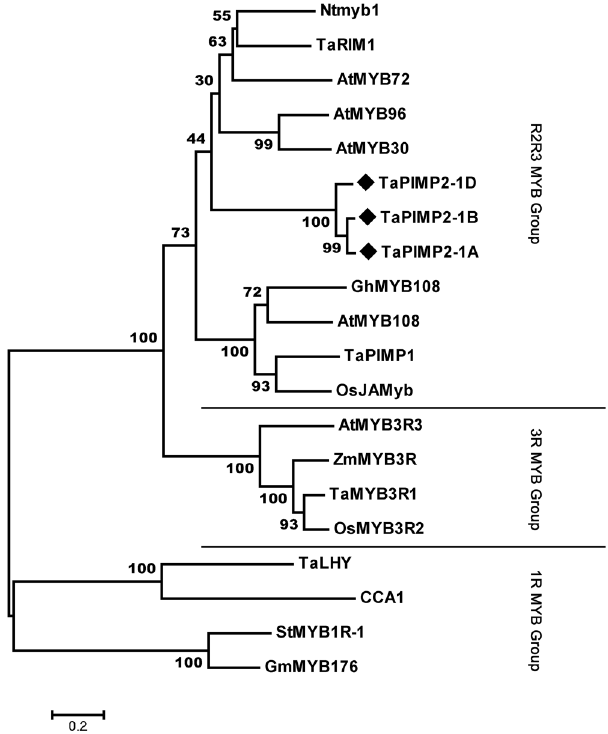
Figure 2. A phylogenetic analysis of 18 known-functional MYB members from 8 plant species. TaPIMP2 from wheat was indicated by black box. The Genbank accession number of proteins including this analysis: Ntmyb1: AAB41101; TaRIM1: AMP18876; AtMYB96: AED97610; AtMYB30: Q9SCU7; AtMYB72: NP_176012; GhMYB108: ALL53614; AtMYB108: Q9LDE1; TaPIMP1: ABU93236; OsJAMyb: AAK08983; AtMYB3R3: NP_001078127; ZmMYB3R3: NP_001151448; TaMYB3R1: ADO32617; OsMYB3R2: NP_001044767; StMYB1R-1: NP_001275346; GmMYB176: ABH02865; TaLHY: ADW09013; CCA1: